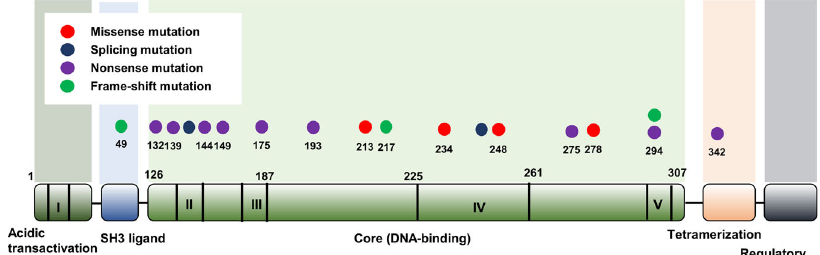
Fig. 1 Types and locations of the TP53 mutations in the 18 patients from the mutant TP53 group. Nonsense mutations of TP53 were most prevalent and were frequently located in exon 5. Each circle indicates patients with TP53 mutation ( n = 18) and the color of circle indicates the type of mutation. The number beneath each circle indicates the location of TP53